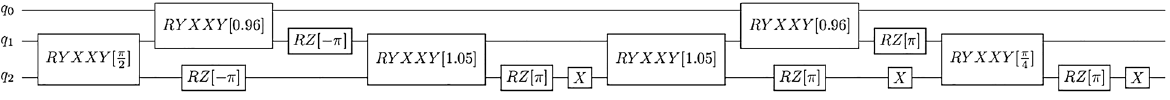
Figure 1. The circuit which generates a ground state of a 3 site Kitaev Hamiltonian at t = − 1 , (cid:31) = 1 and µ = 10 − 8 . A general procedure for obtaining quantum computing circuits which represent the ground state of arbitrary quadratic Hamiltonians is given in Supplementary material Section S1.